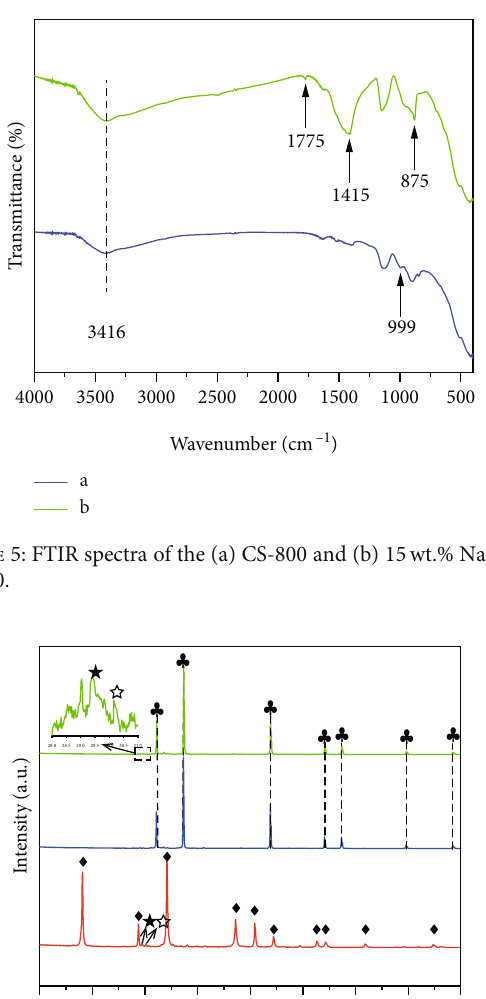
CO -CS-100, (b) CS- 2 3